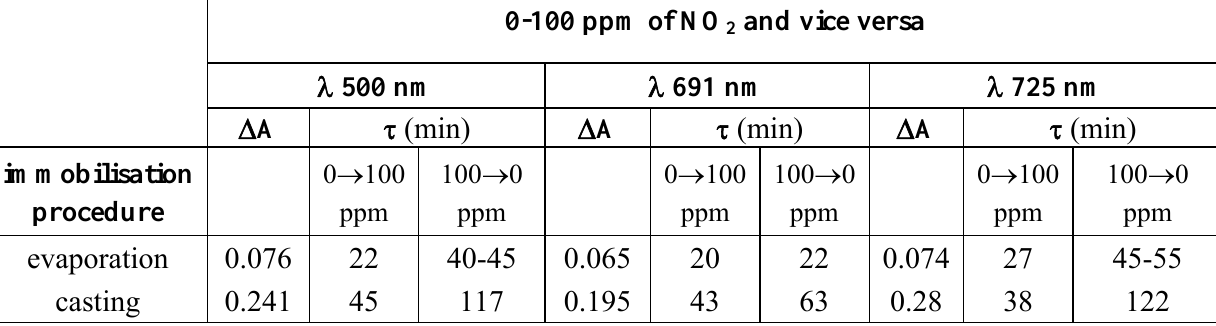
Table 1. Response time ( τ 90%) of the two ‘optodes’ for the step 0-100 ppm of NO vice versa. Reproduced with the permission from reference